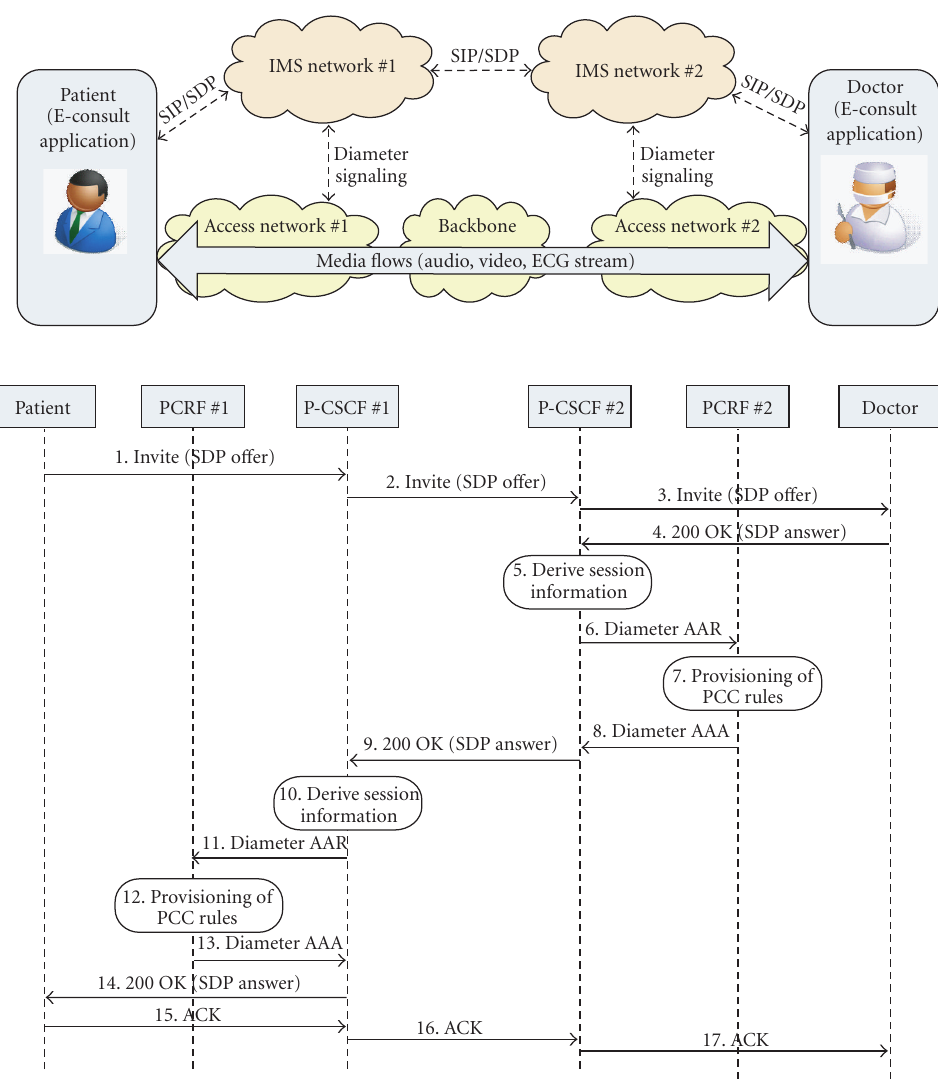
Figure 5: Simplified E-consult network view and session establishment signaling